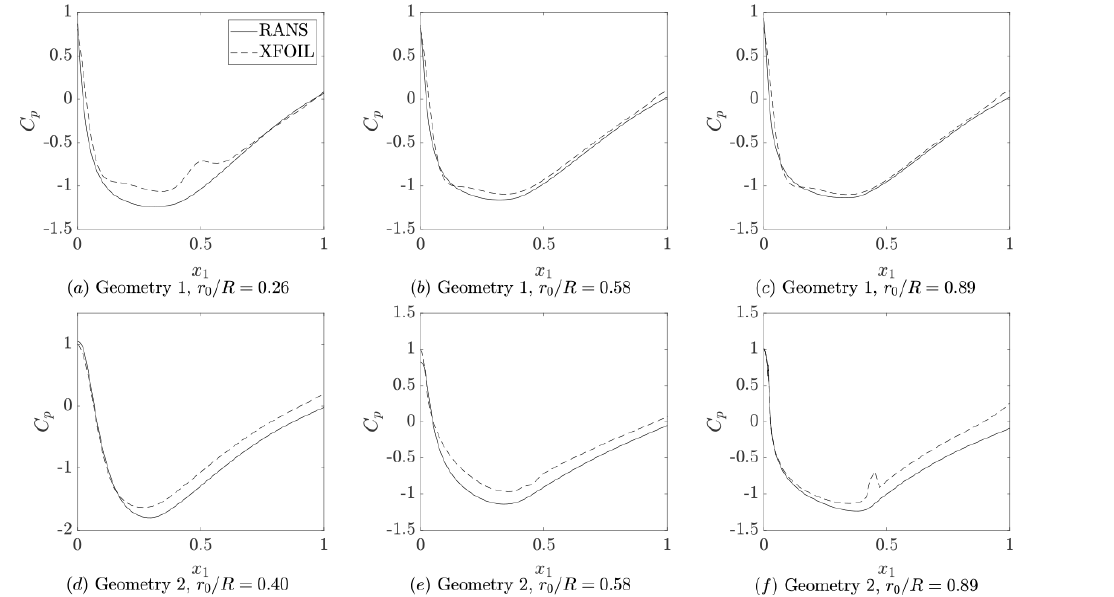
Figure 4. Comparison between XFOIL and RANS pressure distributions for the suction side of the airfoils of geometries 1 and 2 at three radial